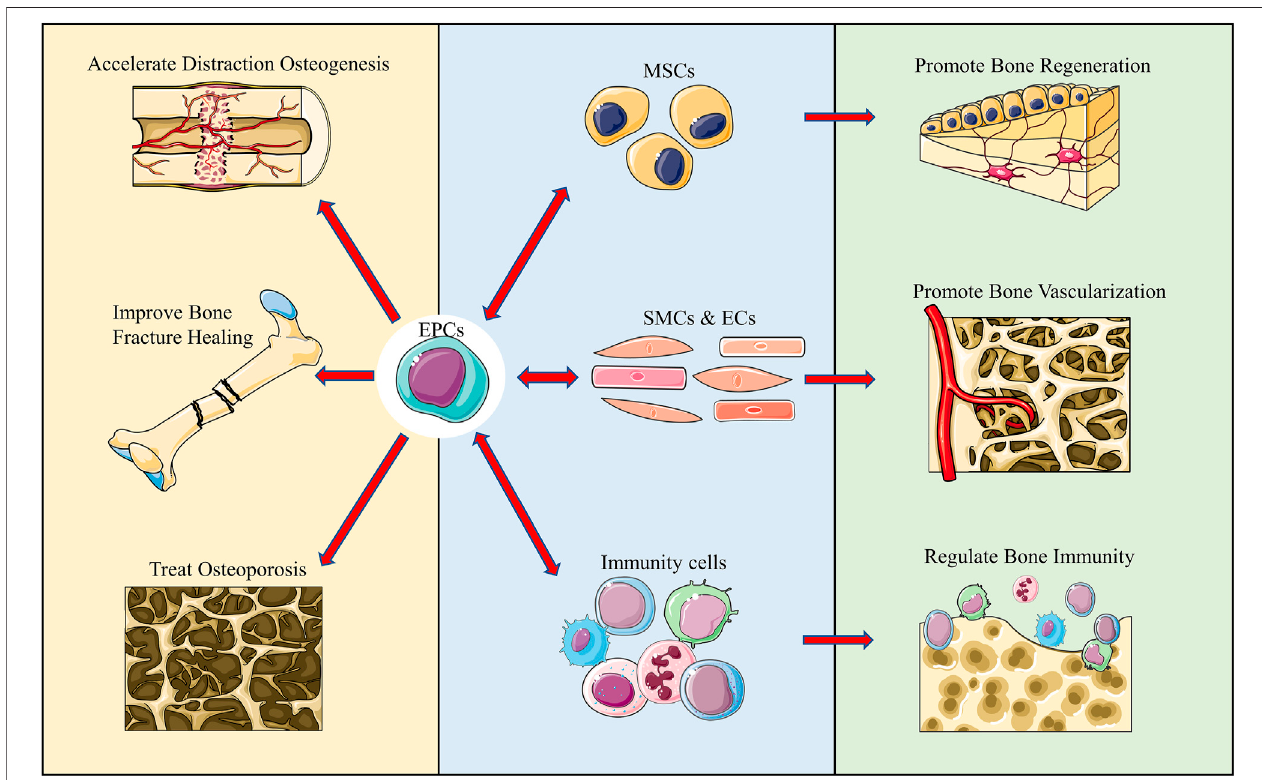
FIGURE 1 | Graphical abstract. We reviewed and summarized the complex interactions of EPCs with multiple cells in bone regeneration, vascularization, and immunity. Additionally, we summarized the application of EPCs in various disease models and believe that it offers certain directions for future studies.